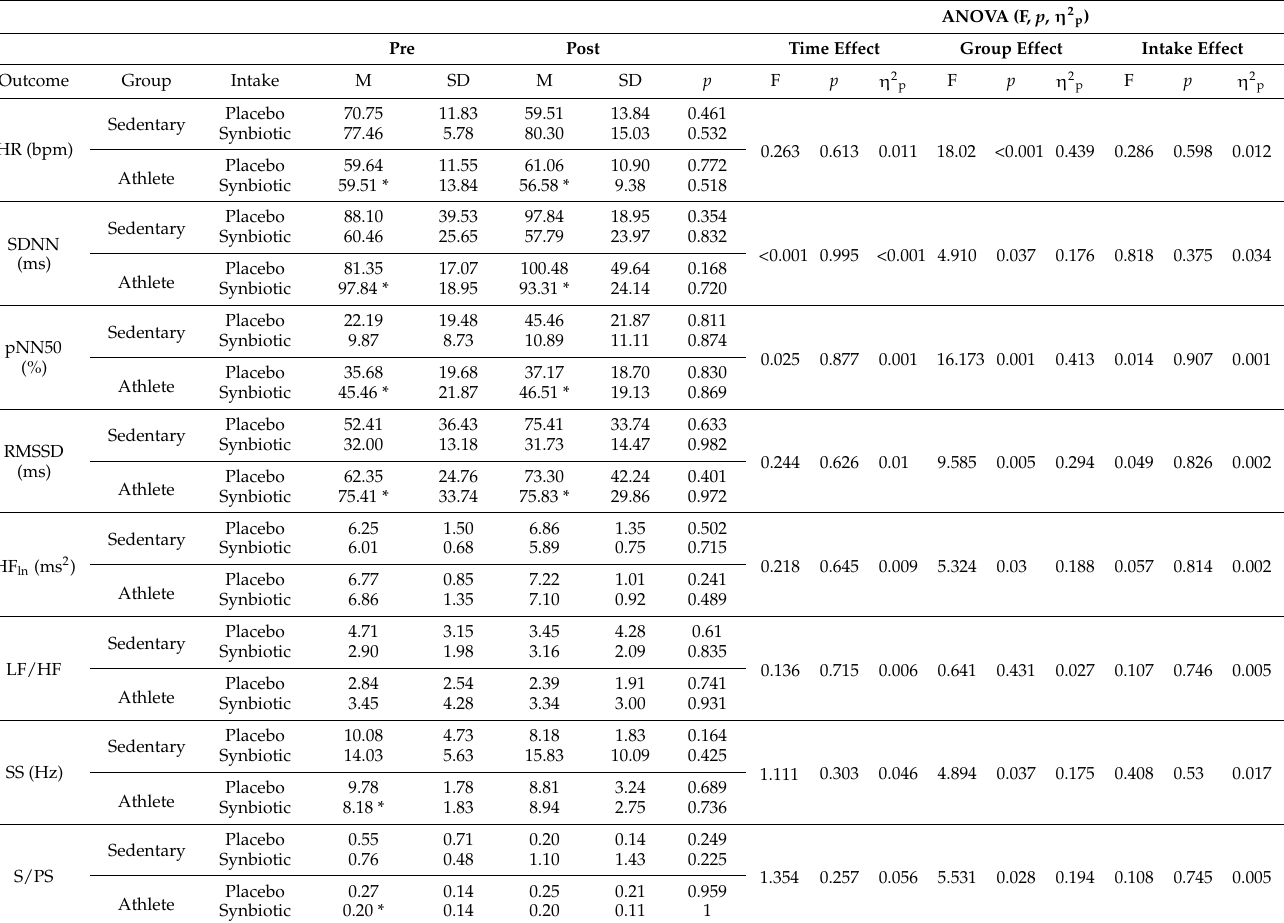
Table 2. Heart rate variability before and after the consumption of a synbiotic or placebo in athletes and sedentary